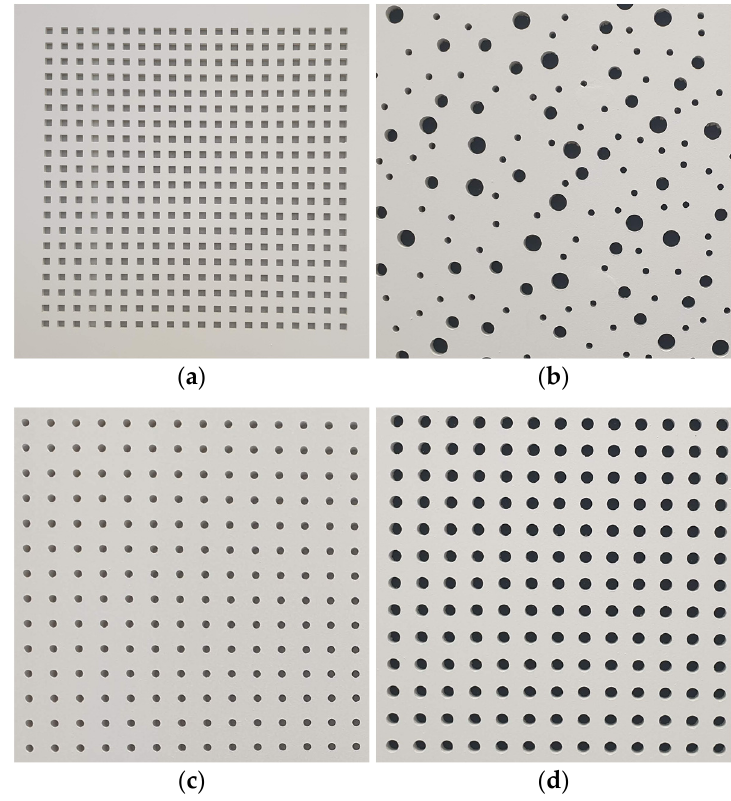
Figure 5. Detail of the perforated plates: ( a ) PRF1; ( b ) PRF2; ( c ) PRF3; ( d ) PRF4. Table 1. Properties of the perforated